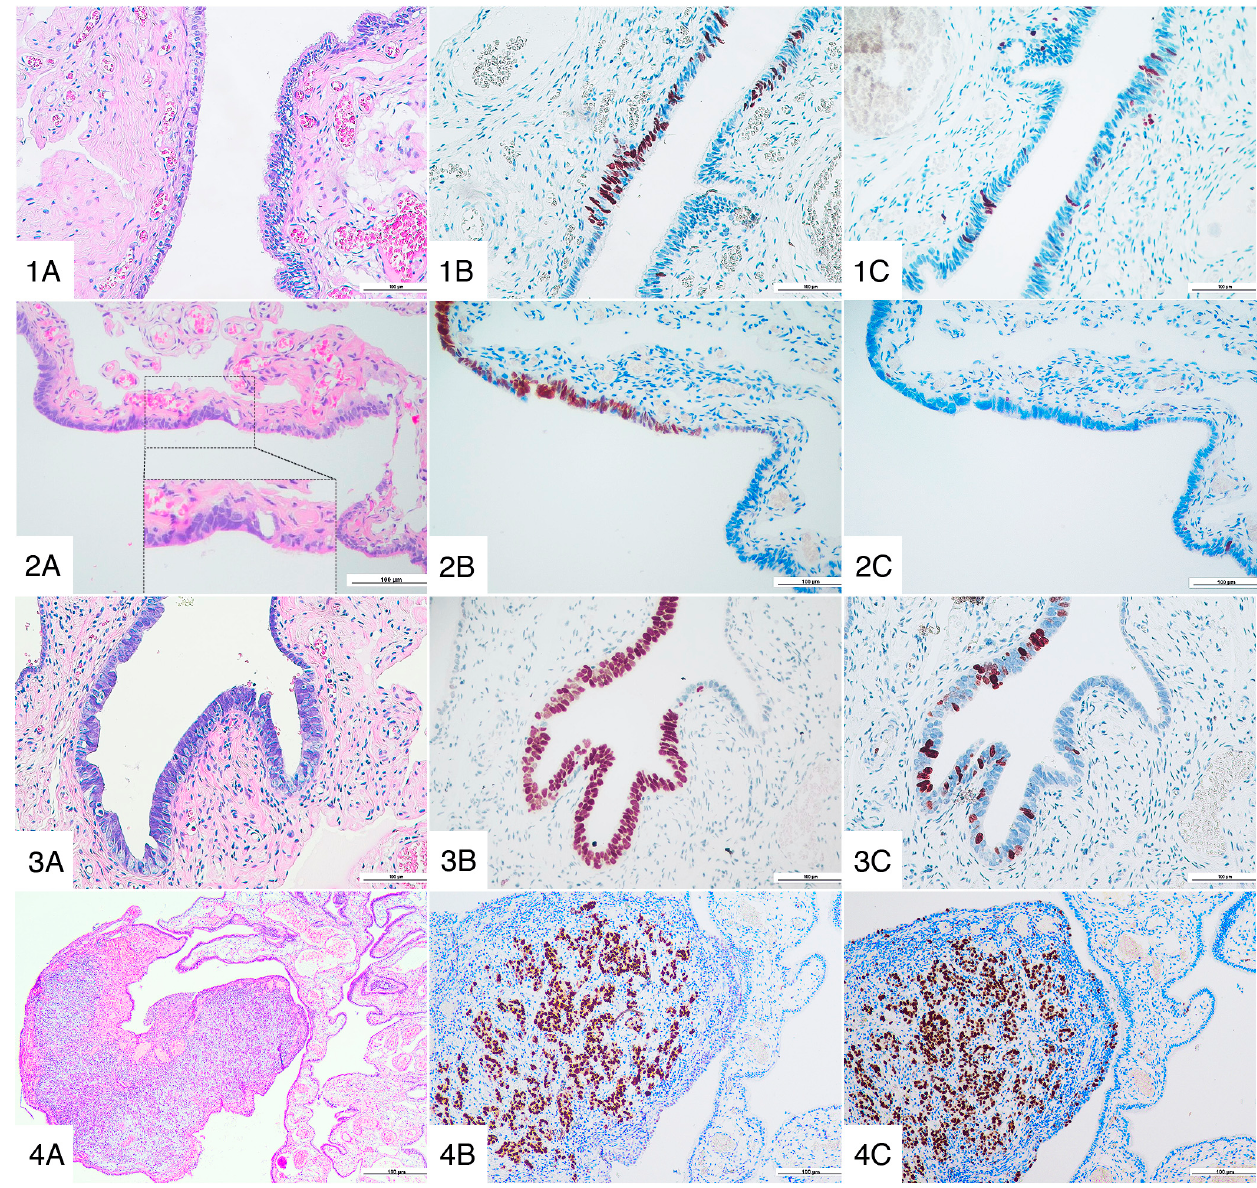
Figure 1. (1) p53 signature histology ( 1A , HE, 10×), p53 immunohistochemical staining ( 1B , 20×) and Ki-67/MIB1 index ( 1C , 20×); (2) STIL histology ( 2A , HE, 20×) with the inset showing the transition between the normal ciliated tubal epithelium on the right-hand of the picture, and the lesion on the left-hand of the inset, p53 immunohistochemical staining ( 2B , 20×) and Ki-67/MIb1 index ( 2C , 20×); (3) STIC histology ( 3A , HE, 20×), p53 immunohistochemical staining ( 3B , 20×) and Ki-67/MIB1 index ( 3C , 20×); (4) invasive high grade serous carcinoma of the fallopian tube ( 4A , HE, 4×), p53 immunohistochemical staining ( 4B , 10×) and Ki-67/MIB1 index ( 4C , 10×).